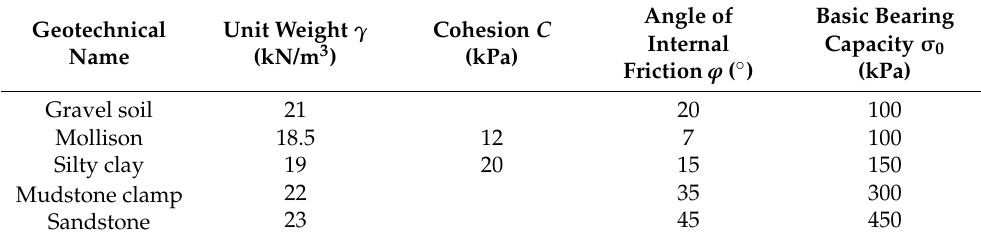
Table 1. Material property parameters of main stratum types of excavated